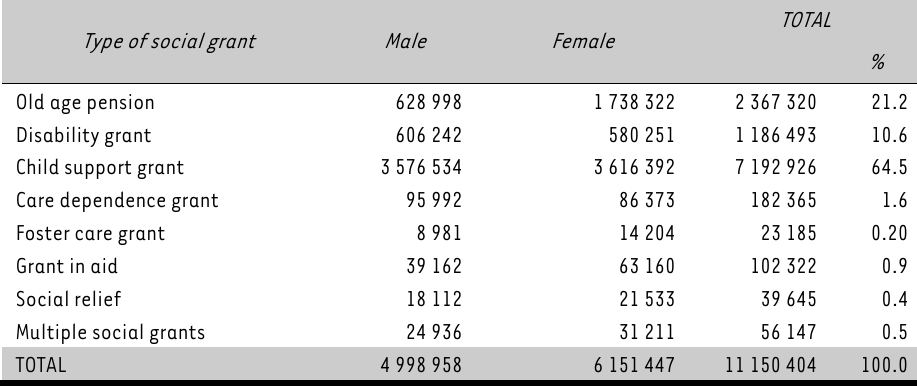
Number Of Males And Females Receiving State Old-Age Pensions Type of social